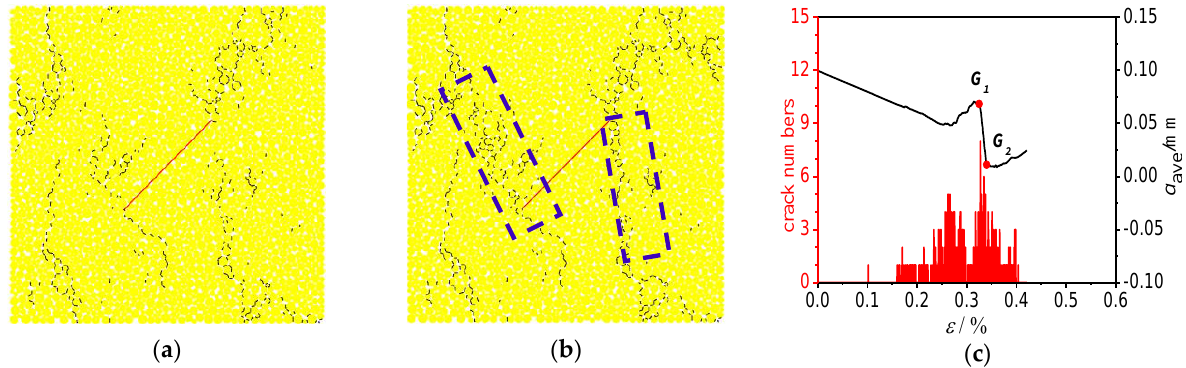
Figure 19. Breakage distribution of contact bonds in the matrix of the specimen with β = 45 ◦ at ( a ) Point G 1 and ( b ) Point G 2 , and ( c ) the variation trends of α ave and the number of crack elements over axial strain.